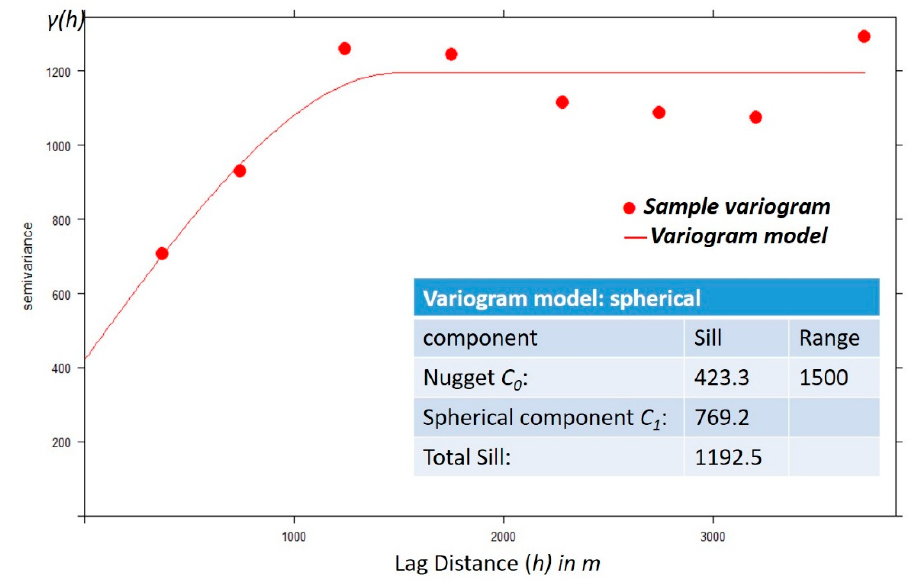
Figure 3. Experimental semivariogram with the spherical model fitted at Amyntaio mine